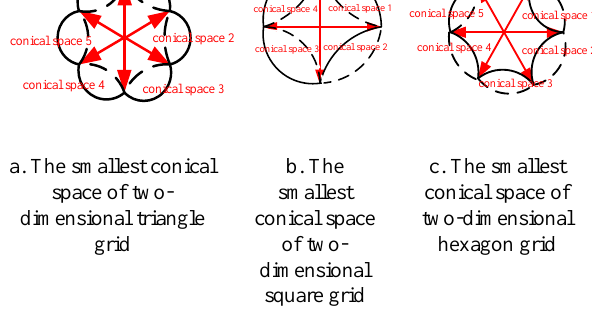
Figure 3. Schematic diagram of the smallest conical